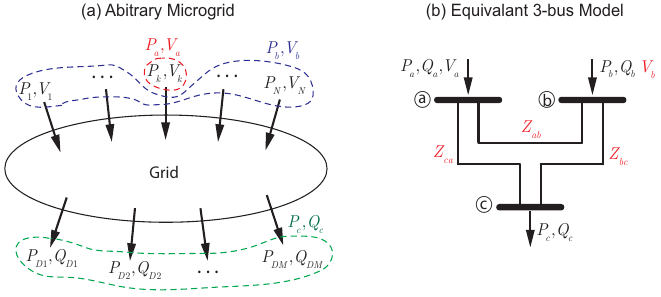
Figure 1. ( a ) Conceptual structure of an islanded microgrid with multiple sources and loads; ( b ) The equivalent 3-bus model of the microgrid. The symbols in black are is a lumped quantity that represents the measured and the symbols in red are unknowns. V b equivalent voltage of the rest of